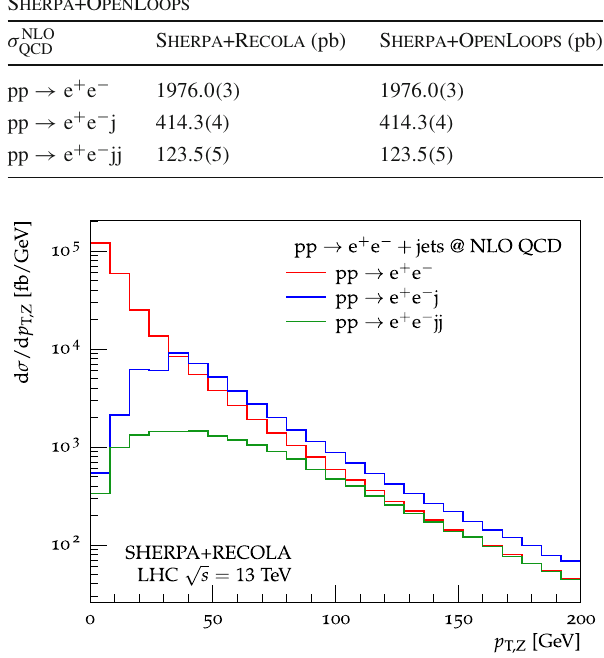
Fig. 1 The transverse-momentum distribution of the reconstructed Z boson in Drell–Yan plus zero, one and two-jet production at NLO QCD nated by the pure Drell–Yan process, i.e. without additional final-state jets at the Born level, where the finite recoil origi- nates solely from the real radiative corrections. On the other hand, the tail of the transverse-momentum distribution is dominated by Drell–Yan-plus-one-jet processes, where the Z transverse momentum results from the recoil against the Born-level jet and the real